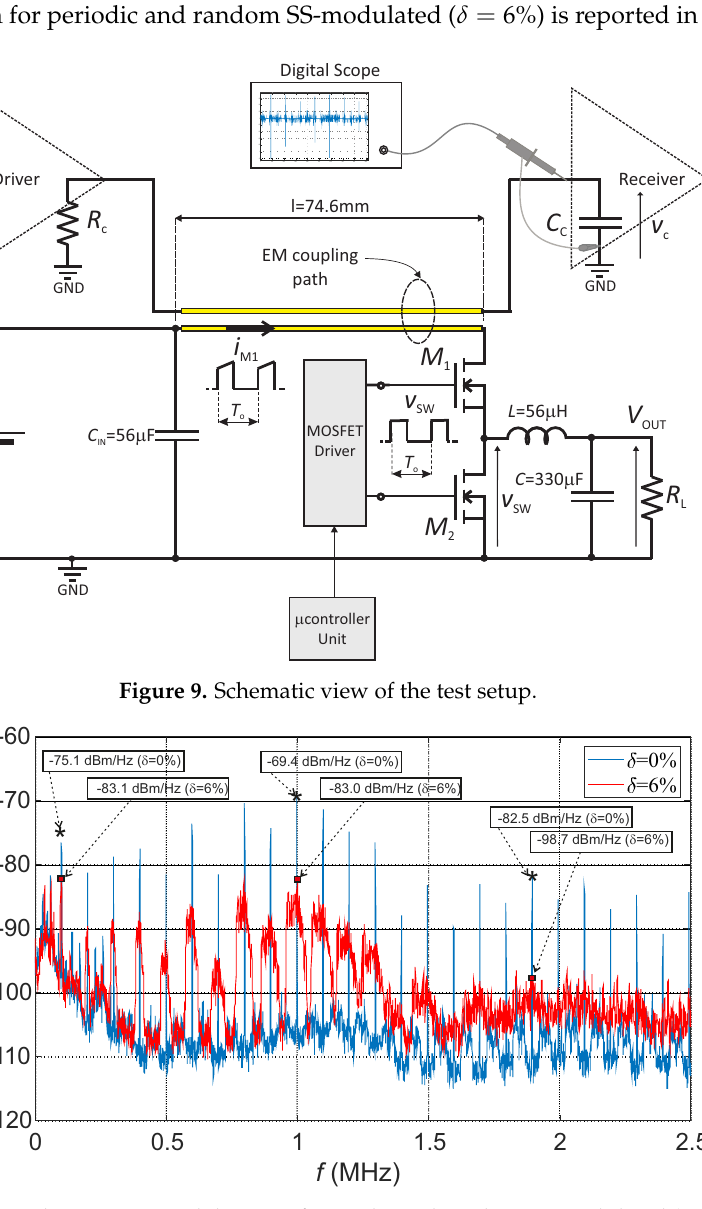
Figure 10. Measured power spectral density of periodic and random SS-modulated ( δ = 6%)